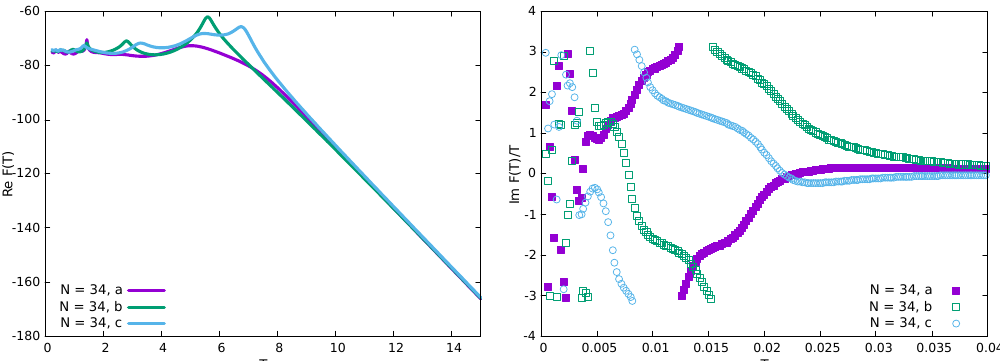
Figure 9: Left: Real part of the free energy for a single disorder realization of the Hamiltonian (92) for N = 34 and z = re i θ = 0. We consider a few disorder real- izations in order to illustrate the dependence of the results on the choice of random couplings. This dependence is relatively minor. In all cases, we do observe clearly a flat part for low temperature and a rather abrupt decreases at a finite temperature T consistent with a first order phase transition. This is similar to both the prediction c of gravity of the previous section and also the free energy after ensemble average of the two-site complex SYK [ 48 ] related to a Euclidean wormhole. Right: Imaginary part of the free energy for the same parameters. Results are rather sensitive to the details of the disorder realization.